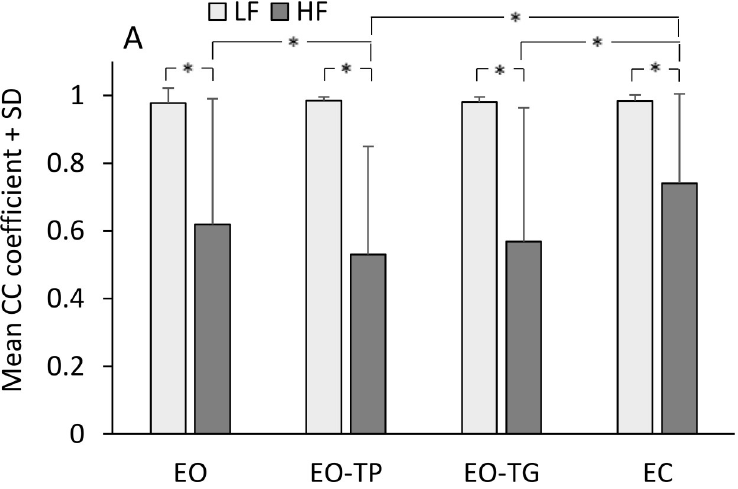
Fig 6. Mean CC coefficient between head and pelvis. Light grey bars correspond to LF, dark grey bars to HF. CC coefficients were always positive, indicating a synchronous displacement of head and pelvis. The CC coefficients are greater at LF than HF. Asterisks indicate significant differences (p <